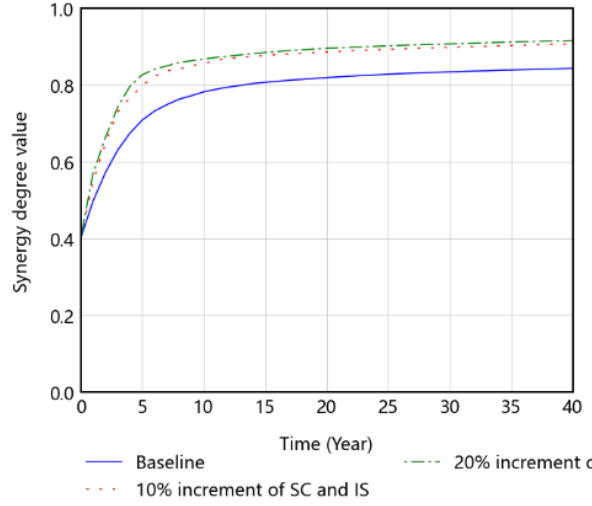
Figure 18. The effects of different degrees of SC and IS on synergy.